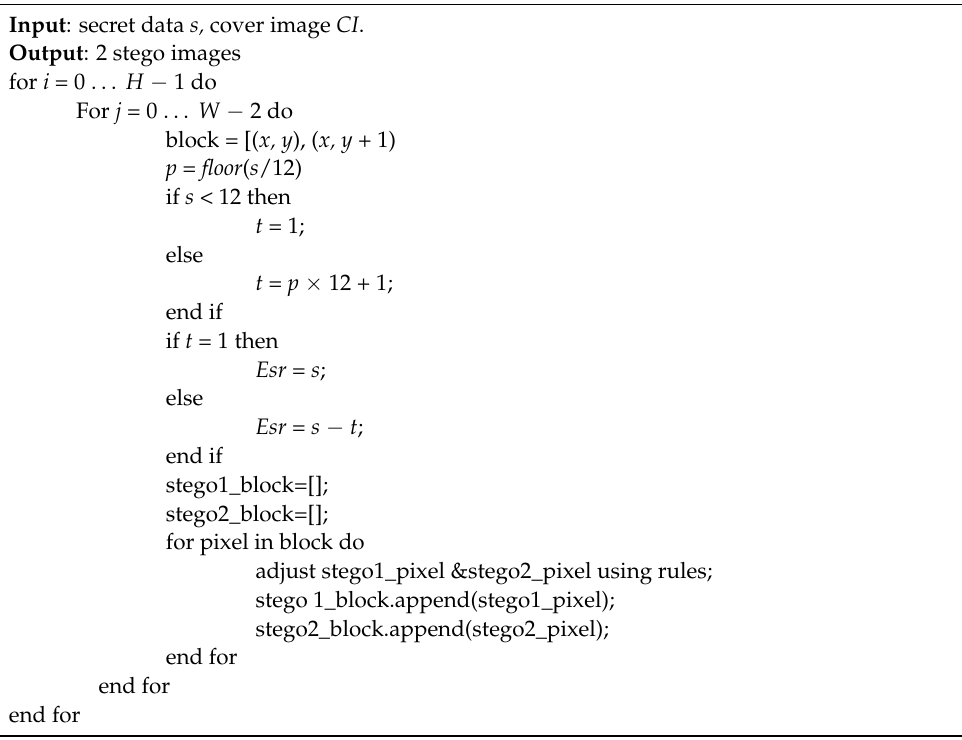
Algorithm 1 Embedding Algorithm